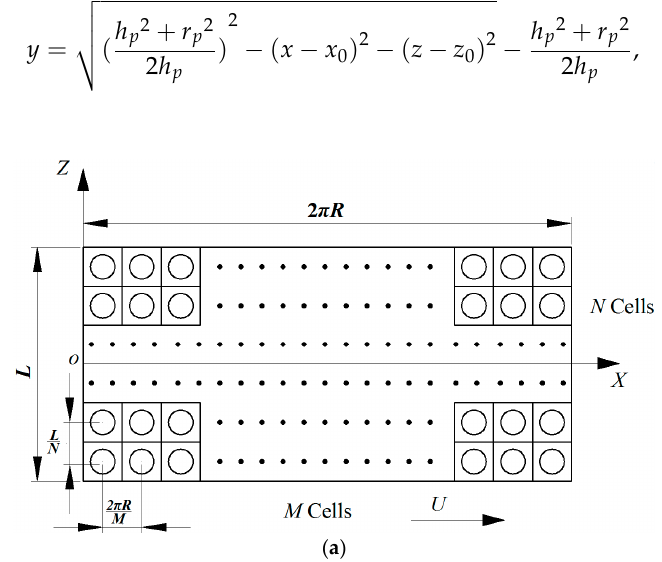
Figure 1. Schematic of the journal bearing.